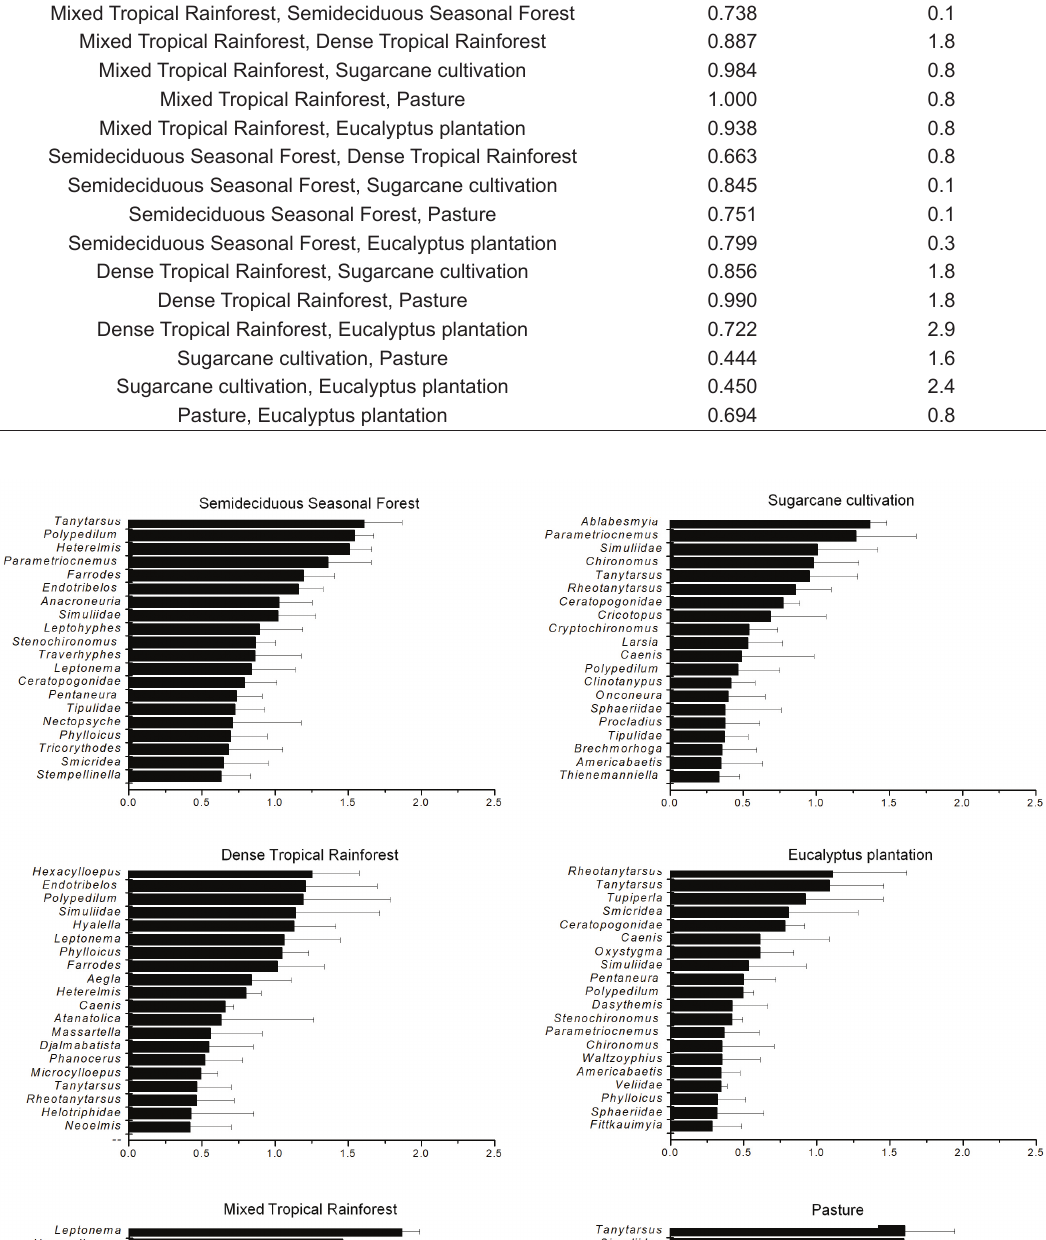
Table 3. Values of analysis ANOSIM ( p <0,05%) for the groups of studied streams of low order in São Paulo State. Groups of streams